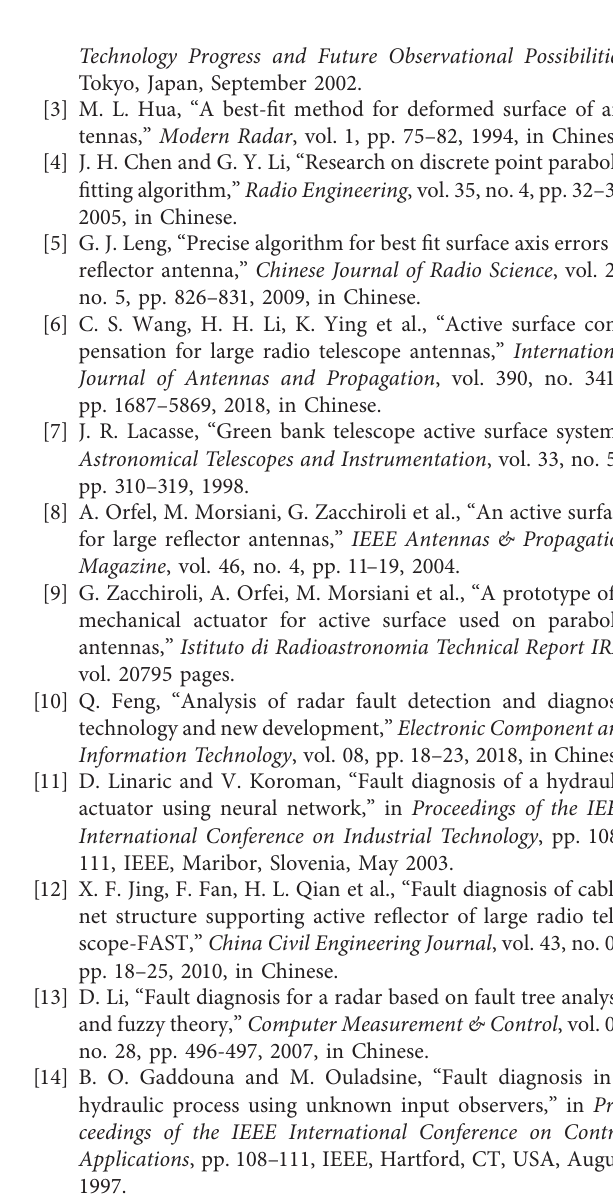
Figure 12: Compare with the main reflector deformation at 70deg elevation. (a) The reflector deformation before actuator failure. (b) The reflector deformation after actuator failure. (c) The reflector deformation at tolerance